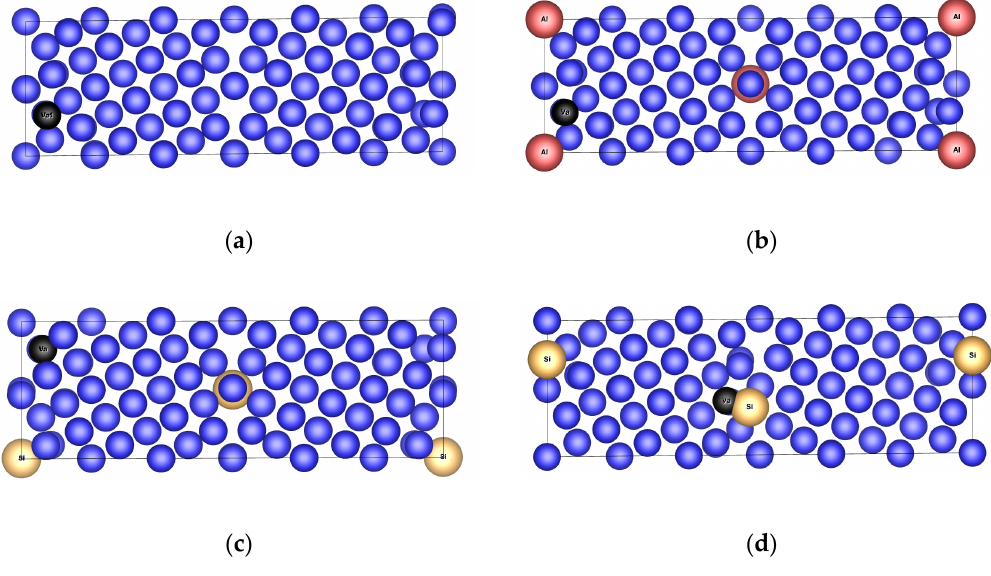
Figure 7. The structures with the lowest energies: ( a ) GB-Ni 119 + Va L2 , ( b ) GB-Ni 117 Al 2(s) + Va L2 , ( c ) GB-Ni 117 Si 2(s) + Va L2 , ( d ) GB-Ni 119 Si 2(i) + Va L3 . Here, the denoted positions of impurities correspond to the general positions shown in Figure 1b. The dark particles denote the positions of vacancies.